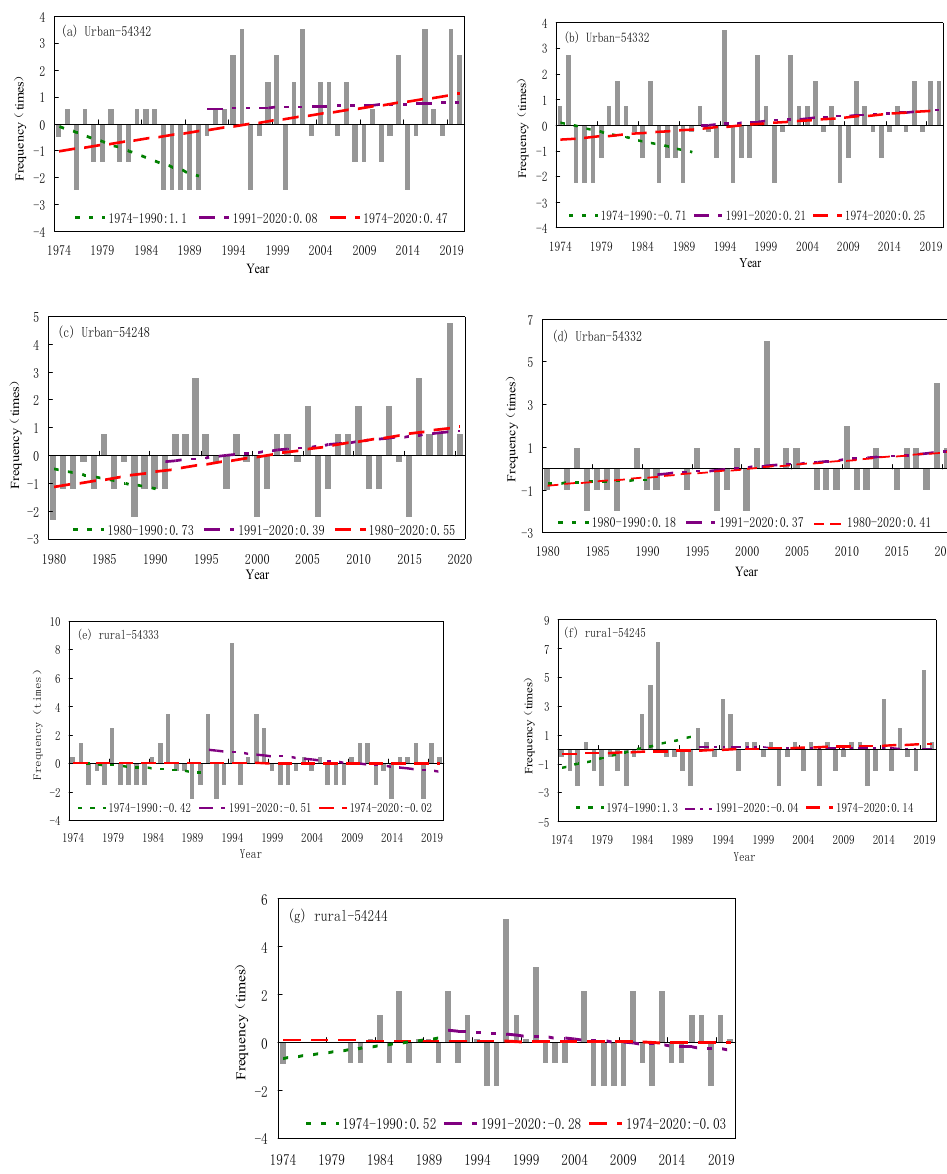
Figure 8. Annual ExHP frequencies at urban representative stations ( a – d ) and rural representative stations ( e – g ) in Shenyang from 1974 to 2020.